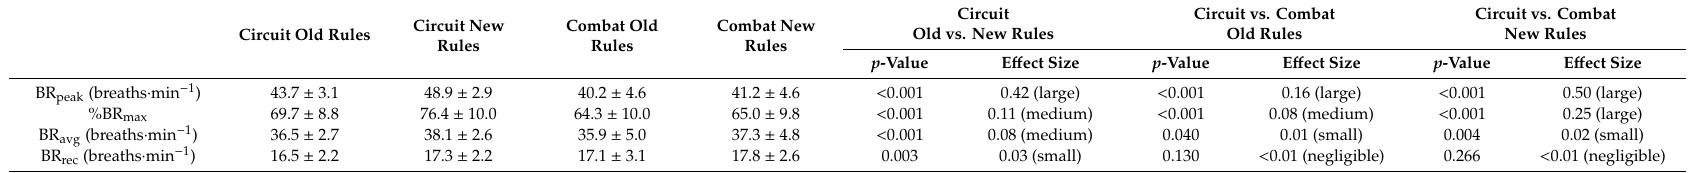
Table 3. Breathing rate during taekwondo-specific circuit training and combat—comparison between old and new rules. Circuit Old Rules Circuit New